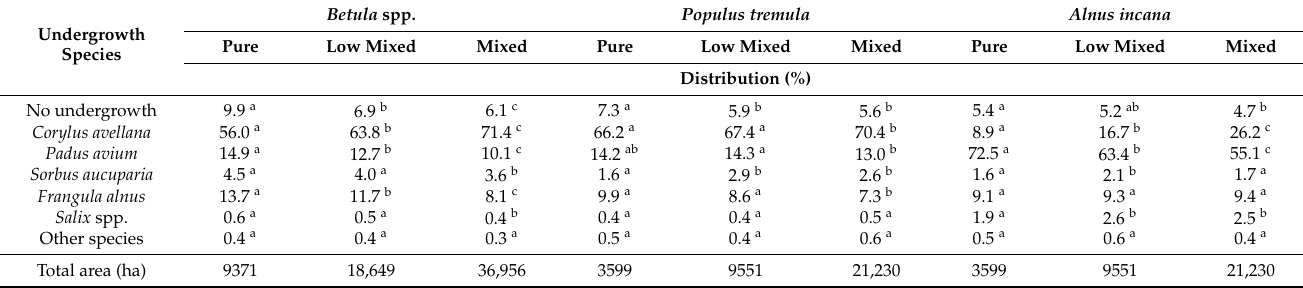
Table 3. Percentage distribution of the predominant undergrowth species area in pure (dominant tree species occupy 86–100%), low mixed (dominant tree species occupy 66–85%), and mixed (dominant tree species occupy less than 65%) Betula spp., Populus tremula , and Alnus incana stands. The values followed by different letters a, b, and c indicate statistically significant differences between pure, low-mixed, and mixed stands within each stand at p <